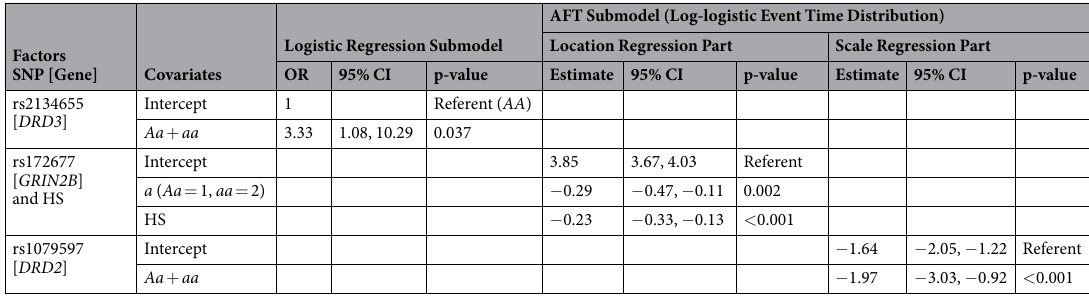
Table 3. Analysis of multiple SNPs and habitual smoking by using the logistic-AFT mixture regression model with chi-squared statistic 21.30 (p < 0.001) of the likelihood ratio test in the mixture model. Abbreviations: HS, Habitual smoking (Yes = 1, No = 0); OR, odds ratio; CI, confidence